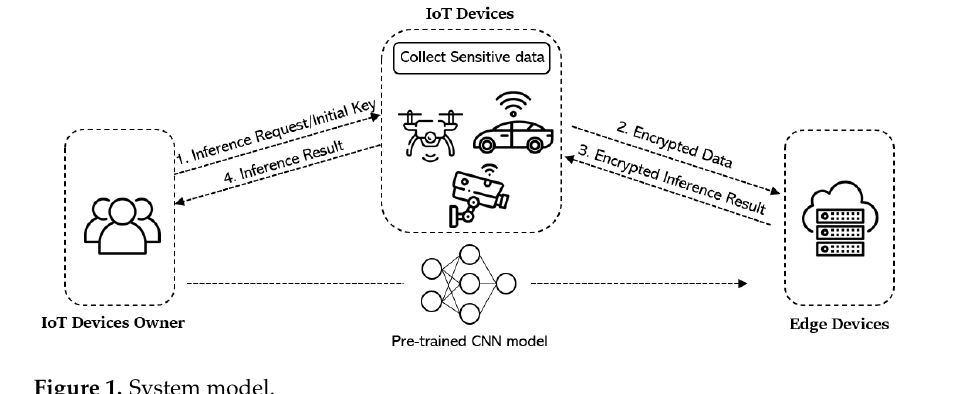
Figure 1. System